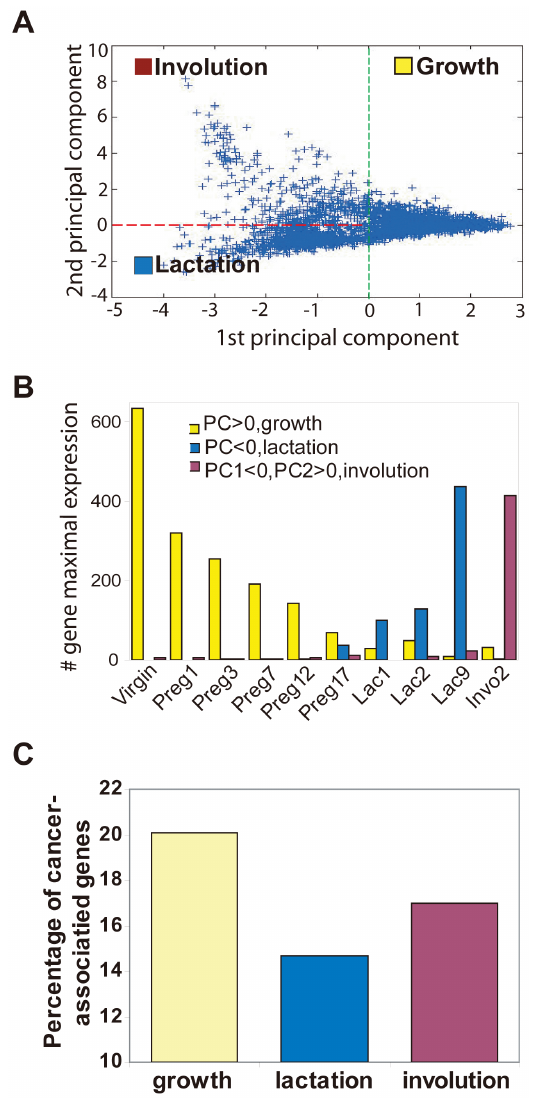
Figure 2. Identification of genes associated with the de- velopmental phases of growth, lactation, and involution among the mammary gland developmentally associated gene subset. A. The developmentally associated genes were clustered into three groups by Principal Component Analysis. Expression profiles of genes in mammary pregnancy cycle are represented as dots in PC1 (1 st principal component axis) and PC2 (2 nd principal component axis). All probe sets were grouped into three groups: growth (PC1 . 0), involution (PC1 , 0&PC2 . 0) and lactation (PC1 , 0&PC2 , 0) based on the number of genes that have peak expression at a particular developmental time (showed in B). B. The time of peak expression for each developmentally associated gene was plotted on a histogram and classified according to the developmental phase (growth, yellow; lactation, blue; involution, purple). The column represents the number of genes that have peak expression at a particular developmental time. C. The frequency of a literature-based cancer modulated genes in the gene subsets associated with the three different stages of mammary gland de- velopment. The ‘‘growth’’ group contained more literature-based cancer modulated genes (20%) than the ‘‘lactation’’ (14.7%) and the involution (17%) groups ( p ,